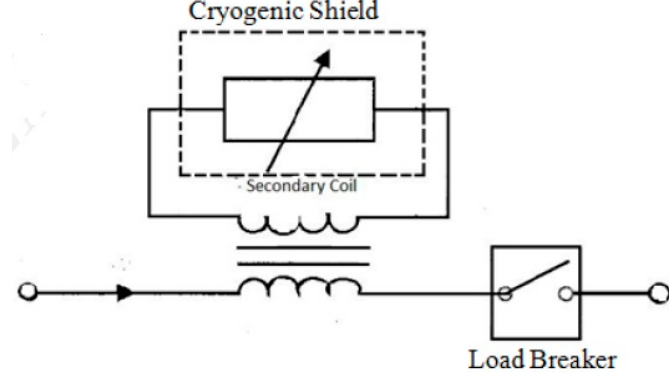
Figure 9. Configuration of inductive shield SCFCL.